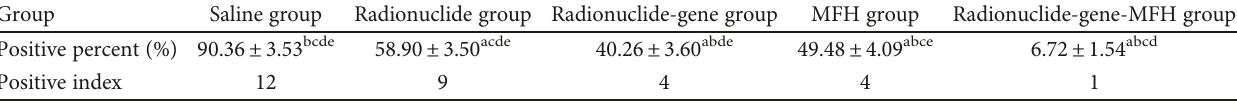
Table 2: Survivin protein expression of hepatoma tissues after di ff erent treatments tested by IHC (mean ± s, n = 5 ). Group Saline group Radionuclide group Radionuclide-gene group Positive percent (%) 90.36 ± 3.53